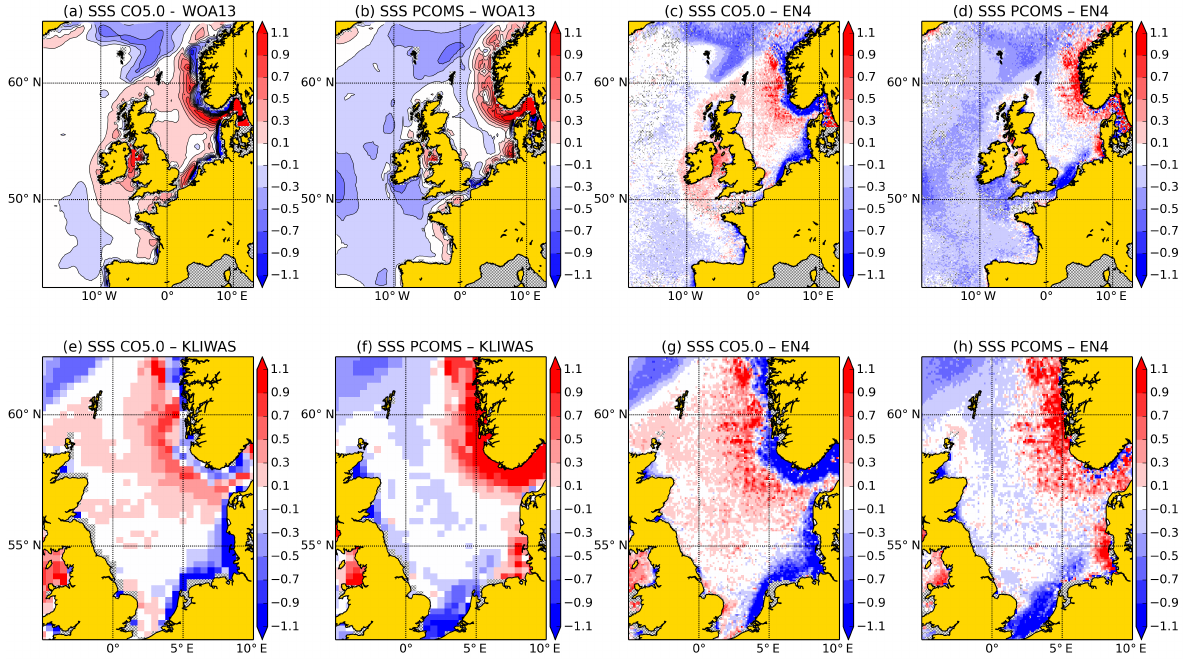
Figure 7. Mean model sea surface salinity (SSS) differences 1985–2004 from WOA13, KLIWAS and EN4: (a) CO5 – WOA13 climatology, (b) POLCOMS – WOA13 climatology, (c) O5 – EN4, (d) POLCOMS – EN4, (e) CO5 – KLIWAS North Sea climatology, (f) POLCOMS – KLIWAS North Sea climatology, (g) CO5 – EN4 in the North Sea and (h) POLCOMS – EN4 in the North